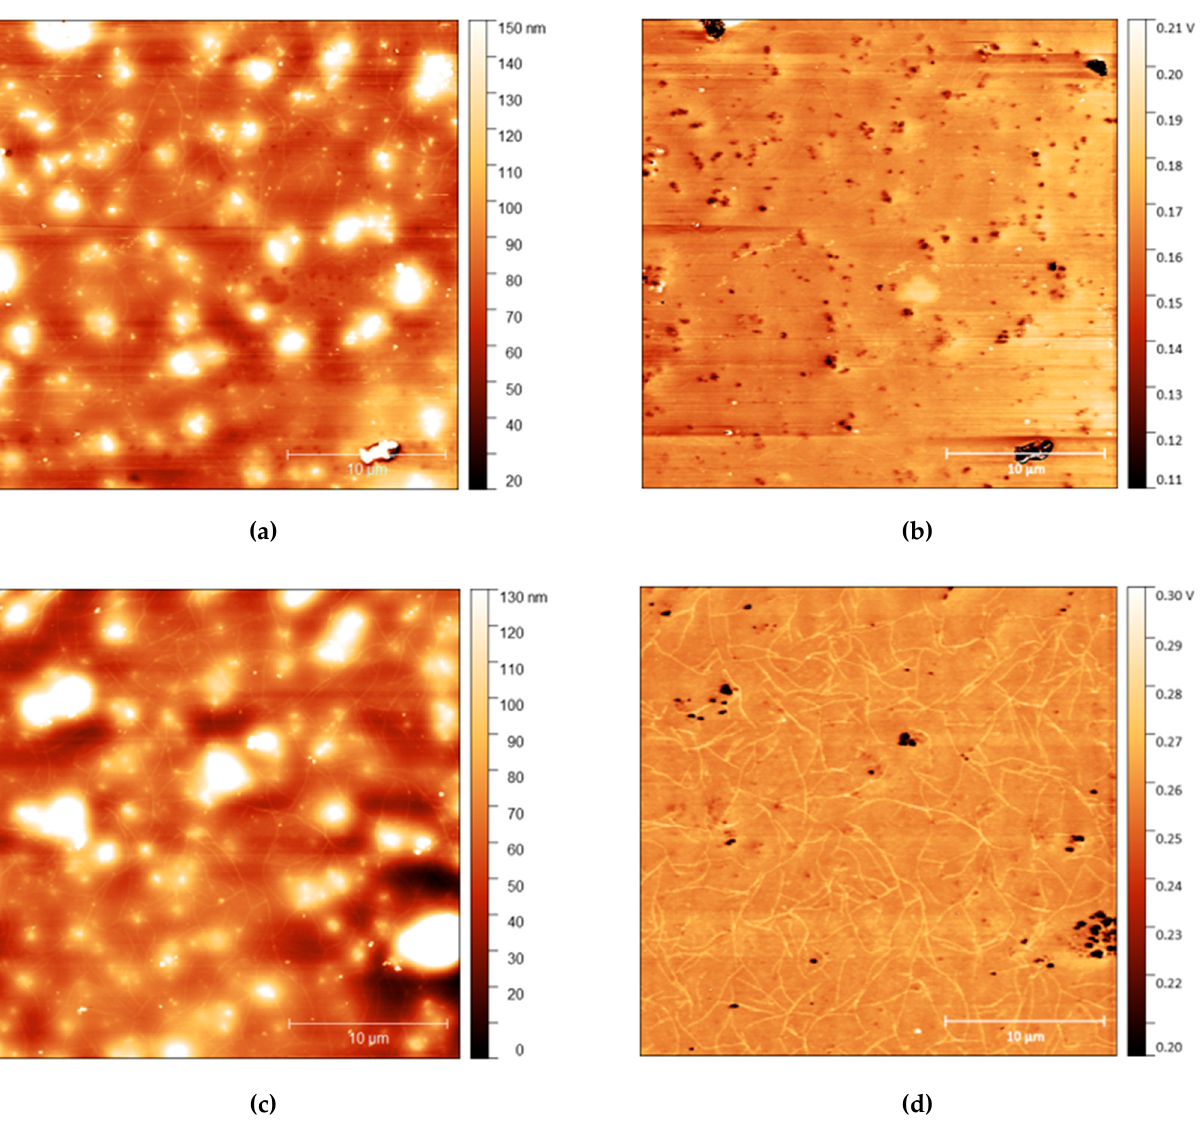
Figure 6. ( a ) AFM height map of cis -PI films with 10% loading of C 12 E 5 and ( b ) Adhesion maps for the same position on the Figure 6. (a) AFM height map of cis -PI films with 10% loading of C 12 E 5 and (b) Adhesion maps for the same position on 299 same film; ( c ) height map of the same film shown in the top AFM images after 10 s rinse and ( d ) the adhesion the same film; (c) height map of the same film shown in the top AFM images after 10s rinse and (d) the adhesion map. 300